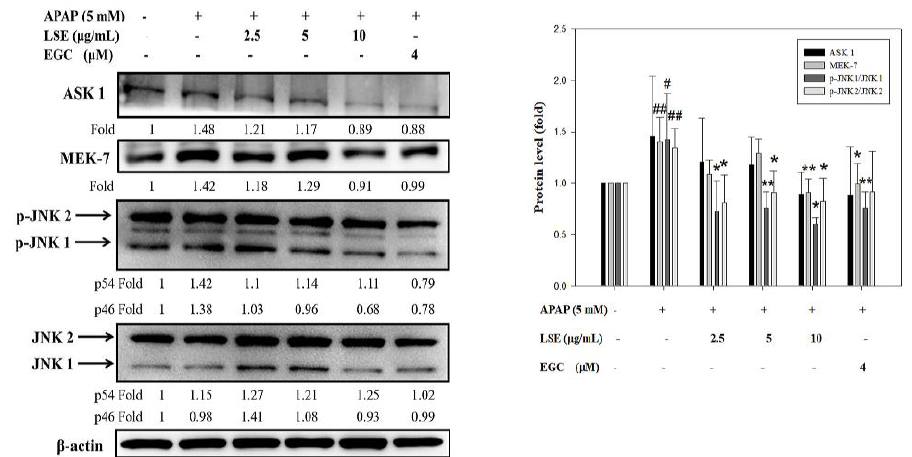
Figure 4. Effect of LSE and EGC on ASK 1/MEK-7/JNK signaling pathways in toxic APAP-treated HepG2 cells. HepG2 cells were treated with APAP (5 mM) in the presence or absence of LSE (2.5, 5, 10 µ g/mL) or EGC (4 µ M) for 24 h. The protein levels of ASK 1, MEK7, JNKs, and p-JNKs were analyzed by Western blotting. β -actin served as an internal control. The quantitative data were presented as means ± SD of three independent experiments. # p < 0.05, ## p < 0.01 compared with the control group. * p < 0.05, ** p < 0.01 compared with the APAP group.